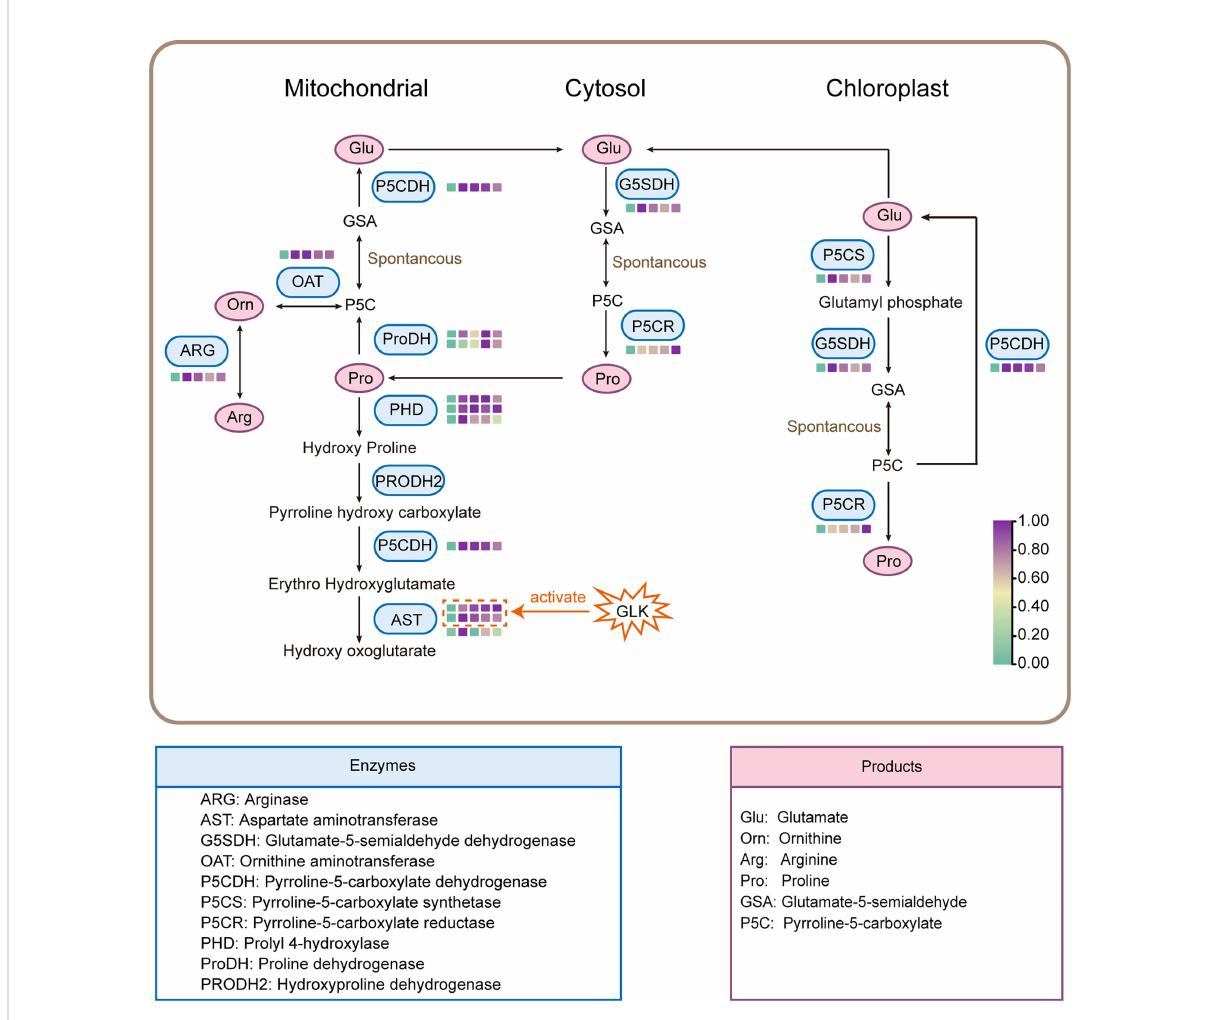
FIGURE 7 Proline biosynthesis and degradation pathway. The color of the box ( □ ) represents the gene expression in different NaCl